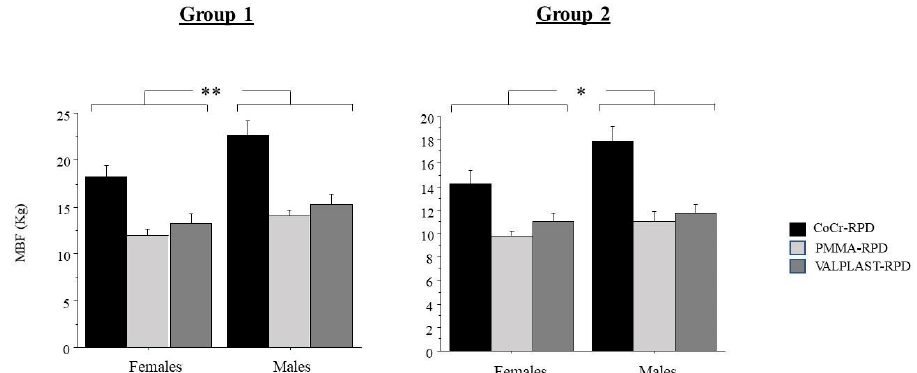
Figure 1. Maximal Bite Force according to gender. MBF = Maximal Bite Force; BMI = Body Mass Index; V-RPD = Valplast Removable Partial Denture; CoCr-RPD = Chrome-Cobalt Removable Partial Denture; PMMA-RPD = Polymethyl Methacrylate Removable Partial Denture. * = p < 0.05; ** = p < 0.01.